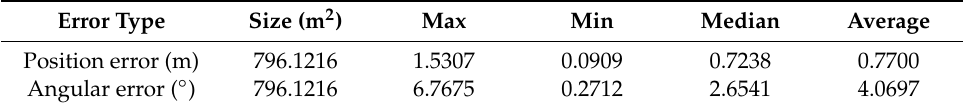
Table 7. Deep learning position results in closed round hall.